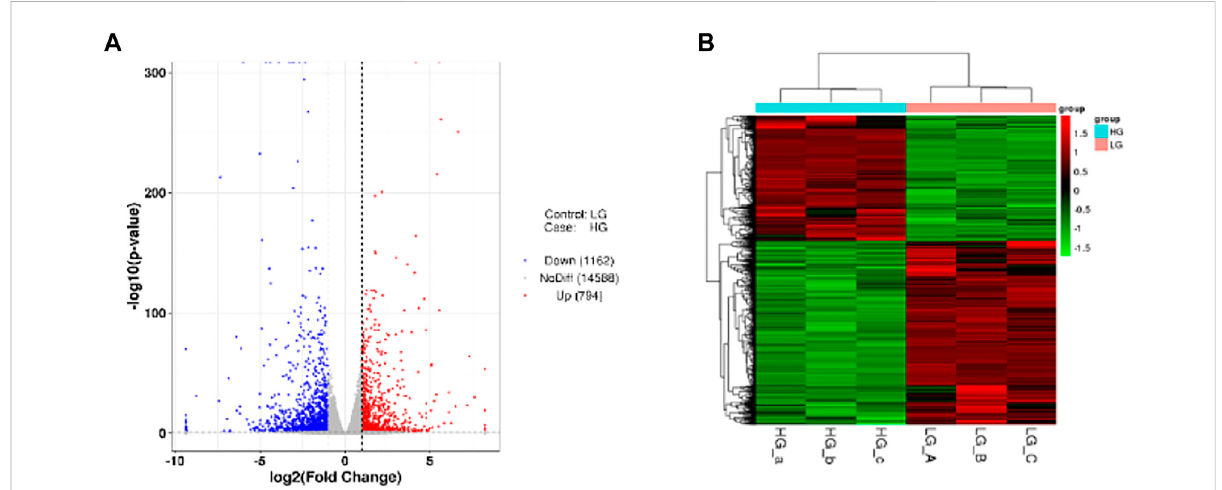
FIGURE 3 DEGsamongthetwogroups. (A) TheVolcanoplot.Thetwoverticaldashedlinesmean2timestheexpressiondifferencethreshold.Thedashed horizontallinestandforthethresholdvalueof p -value=0.05.ThereddotsaretheupregulatedgenesHGgroupvs.LGgroup,whilethebluedotsare the downregulated genes, and the gray dots stand for the genes that are not signi fi cantly differentially expressed. (B) Cluster of differentially expressed genes. Red and green colors represent highly expressed genes and lowly expressed genes,